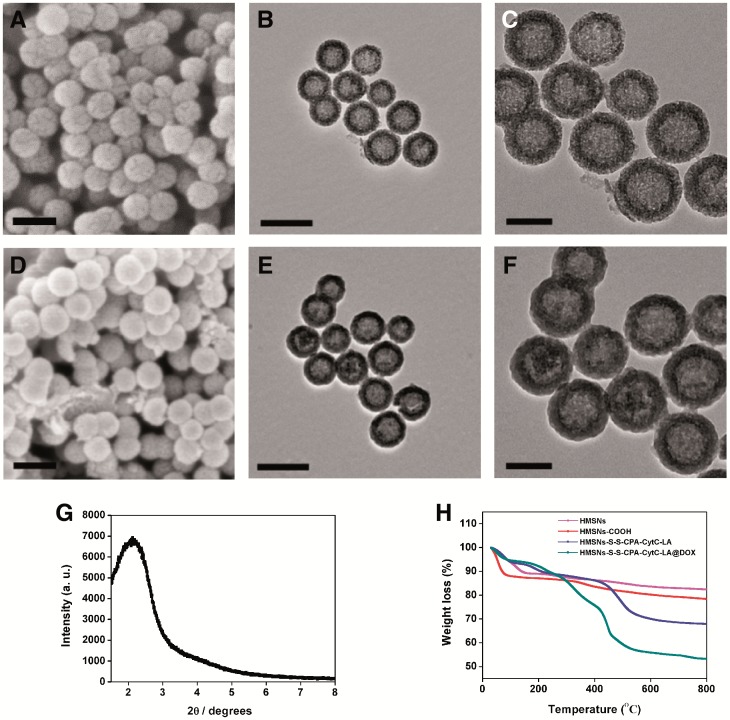
Physical property characterizations: SEM and TEM images of HMSNs (A and B) and HMSNs–S–S–CPA–CytC–LA (D and E) nanoparticles with corresponding high resolution TEM images (C and F). The scale bars were 200 nm for (A), (B), (D) and (E) and 100 nm for (C) and (F); (G) low-angle XRD pattern of HMSNs; (H) TGA curves of various functionalized HMSNs